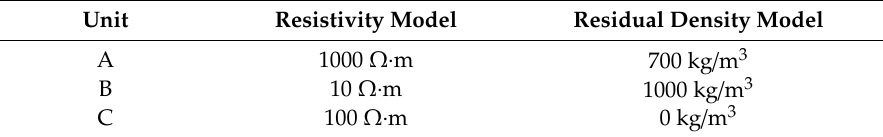
Figure 5. The gravity inversion results obtained using separate and joint inversion. ( a ) Density true model; ( b ) Density separate inversion model using L2 regularization; ( c ) Density separate inversion model using elastic-net regularization; ( d ) Density joint inversion model using L2 regularization; ( e ) Density joint inversion model using elastic-net regularization. The black box indicates the boundary of the anomalous body. Table 2. The resistivities and residual densities of synthetic model